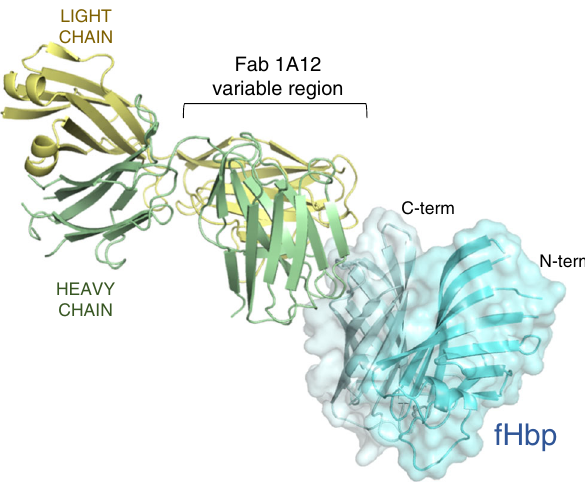
Fig. 2 The Fab 1A12-fHbp complex crystal structure. Ribbon diagram in which the heavy and light chains of Fab 1A12 are colored green and yellow, respectively; fHbp is represented in cyan with a transparent